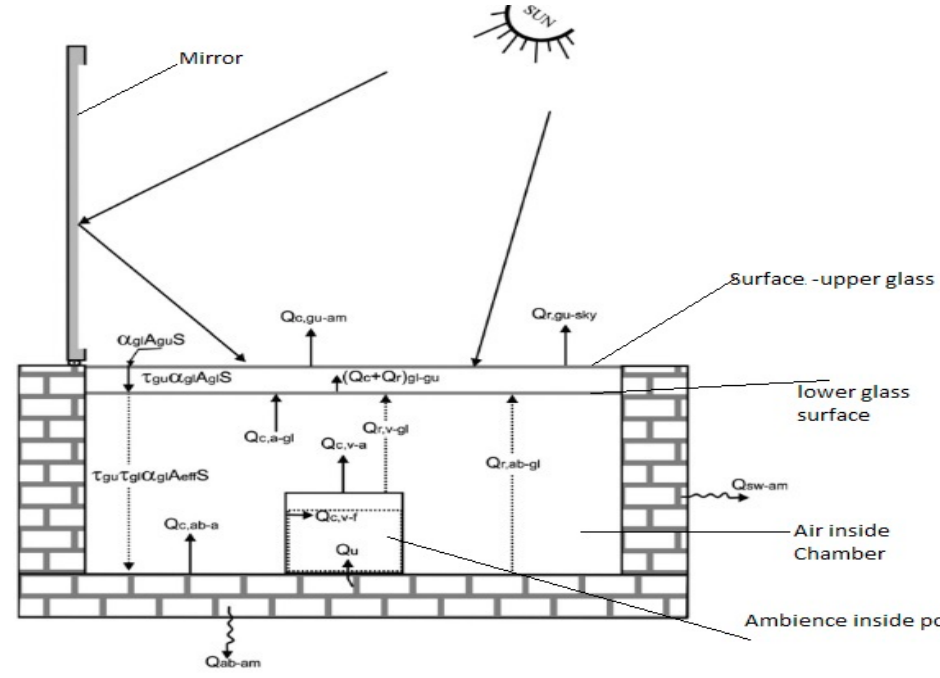
Figure 5. Sketch of a sample solar cooker with heat transient surfaces labeled. Reprinted/adapted with permission from Ref. [29], 2013, AIP Publishing.